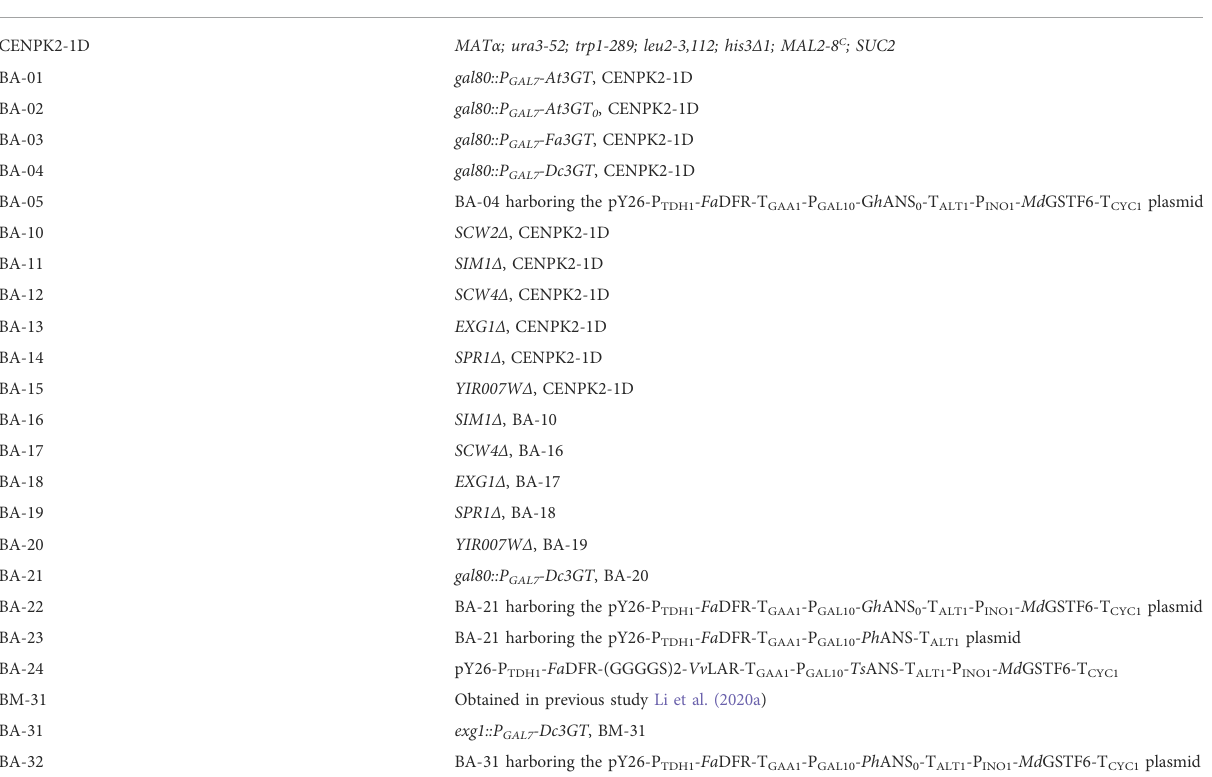
The protein component was fi ltered through a 0.45- μ m fi lter membrane before puri fi cation. ÄKTA Avant 25 (GE Healthcare, WA, United States) equipped with HiLoad 26/600 Superdex 200 pg (GE Healthcare) was used for size-exclusion chromatography. The protein component was loaded at the rate of 5 ml/min, and 20 mm Tris, pH 5.0 was used for elution at the rate of 3 ml/min. The eluates corresponding to different signal peaks were collected. Amicon Ultra Centrifugal Filters of 10k MWCO (Merck, NJ, United States) were used for the protein concentration at 3000 g and 4 ° C until the volume was concentrated to 200 μ l. SDS-PAGE was used for separating the protein concentrates using a NuPAGE 10% Bis-Tris Gel (Thermo Fisher Scienti fi c, MA, United States). The protein bands were excised from the gel. The protein pro fi les provided by Sangon (Shanghai, China) were used for identifying the protein